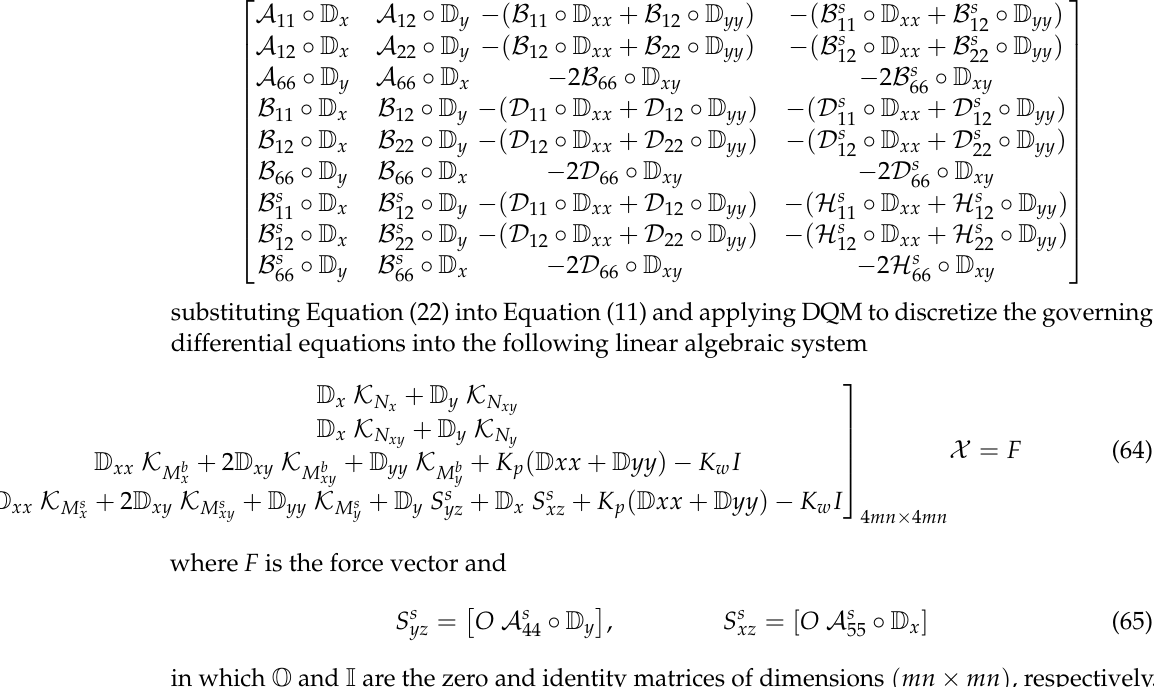
) and ( σ x = h σ x aq 0 q 0 a 4